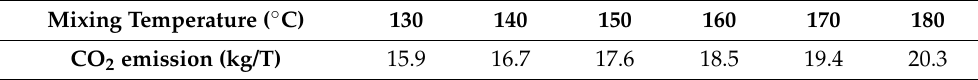
Table 1. Relationship between CO 2 emission and temperature during asphalt-mixture